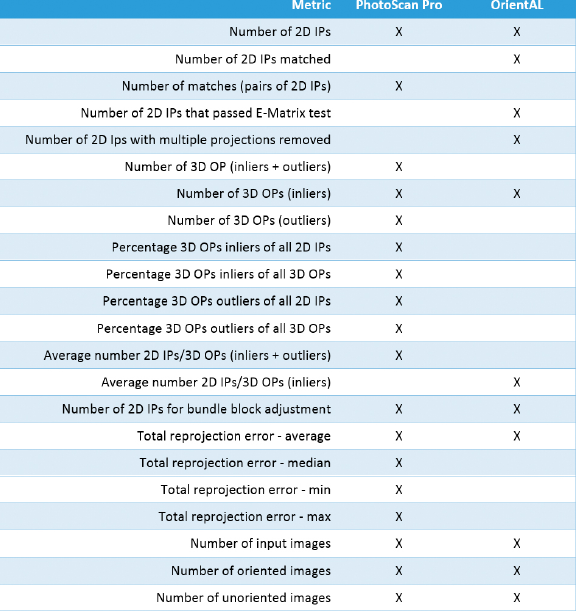
Figure 4. This graph plots the total Reprojection Error (RE) versus the total IP count. Each of the 56 data points (the var and stdv methods are omitted) equals the average of all runs on all seven datasets. Looking at the median IP count versus the median RE, it seems that both are unrelated. However, plotting the average IP count versus the RE (both average and median),